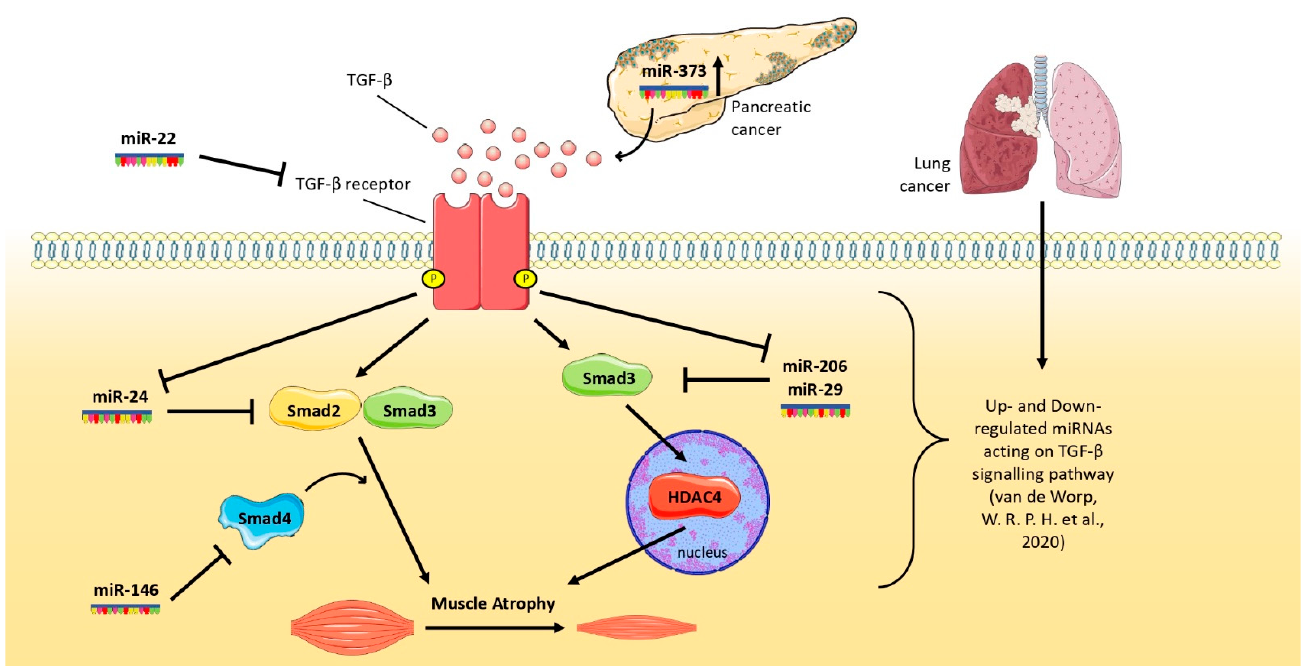
Figure 2. Schematic representation about how selected miRNAs affect the activity of TGF-b pathway in skeletal muscles during lung and pancreatic tumor